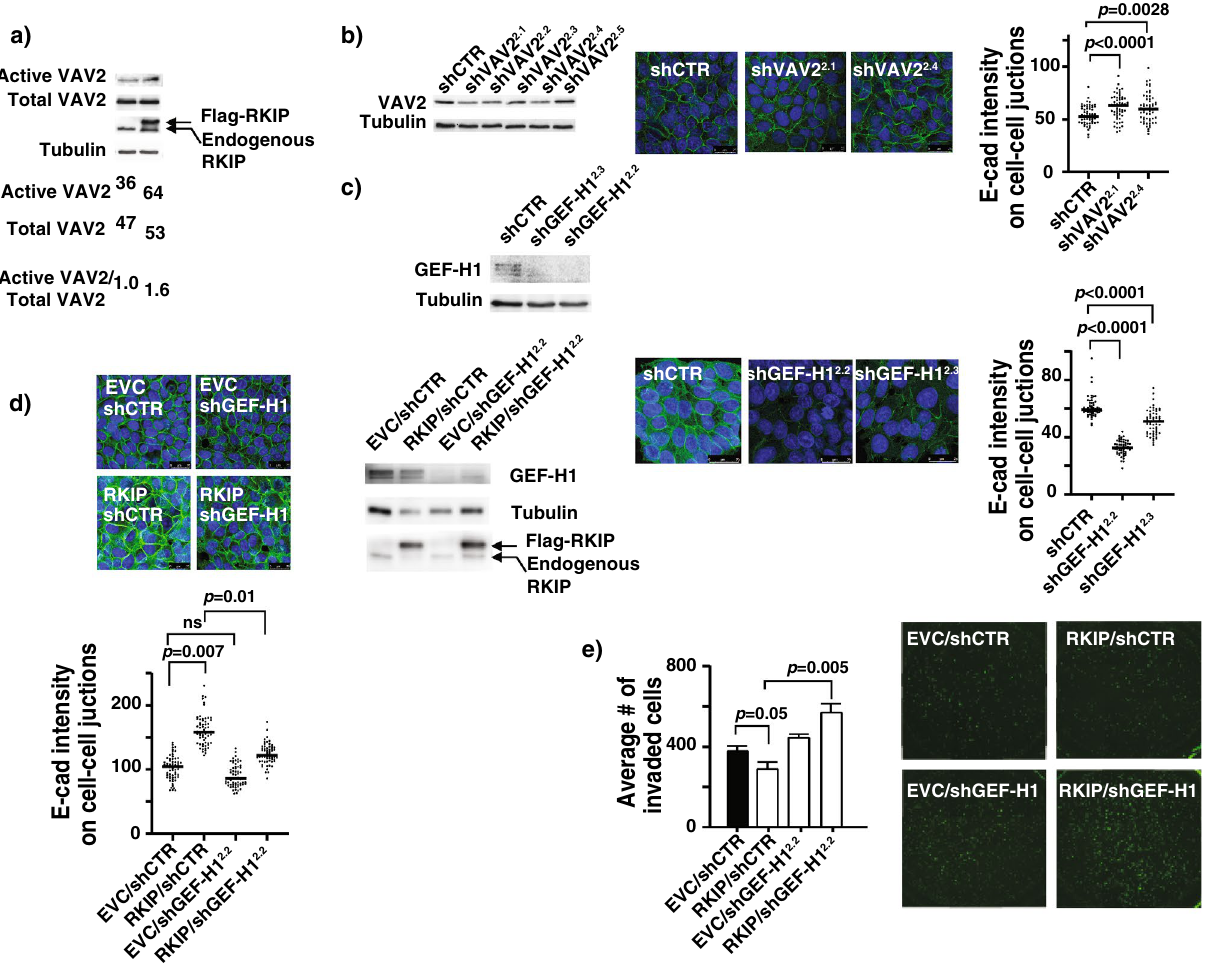
Figure 5. RKIP activates RhoA through GEF-H1. ( a ) Representative western blots of VAV2 GEF activity pull-down assays with lysates prepared from BT20 cells. Numbers are shown for quantified active VAV2 bands normalized with total VAV2 protein. ( b ) (Left panel) Representative western blots of lysates prepared from control knockdown (shCTR), or five different VAV2 knockdowns (shVAV2 2.1–2.5 ) BT20 cells. (Middle panel) Representative images of immunofluorescent staining with E-cad Ab and DRAQ5 of the same set of BT20 cells shown in the left top panel. (Right panel) E-cad intensity quantification on cell–cell junctions of immunofluorescent images shown in the left bottom panels using MetaMorph analysis software. ( c ) (Left panel) Representative western blots of lysates prepared from control knockdown (shCTR), or two different GEF- H1 knockdowns (shGEF-H1 2.2–2.3 ) BT20 cells. (Middle panel) Representative images of immunofluorescent staining with E-cad Ab and DRAQ5 of the same set of BT20 cells shown in the left top panel. (Right panel) E-cad intensity quantification on cell–cell junctions of immunofluorescent images shown in the left bottom panels using MetaMorph analysis software. ( d ) (Top left panel) Representative images of immunofluorescent staining with E-Cad Ab and DRAQ5 of BT20 cells with different combinations of control knockdown, GEF-H1 knockdown (shGEF-H1), empty vector control (EVC) or RKIP expression. (Bottom left panel) E-cad intensity quantification on cell–cell junctions of immunofluorescent images shown in the left bottom panels using MetaMorph analysis software. (Right panel) Representative western blots of lysates prepared from the same set of cells shown in the left panel. ( e ) (Left panel) Representative results of invasion assays with same set of cells used in ( d ) showing number of invaded cells through Matrigel in each indicated BT20 cell lines (mean ± SE). (Right panel) Representative images of the stained invaded cells in indicated cell lines shown at the left panel. Unpaired Student’s t-test (two-tailed) was used for all analyses with p < 0.05 considered significant. ns not